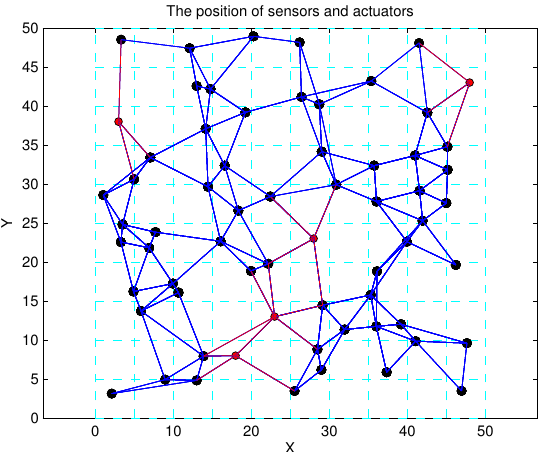
Figure 15. The optimal network structure in Algorithm